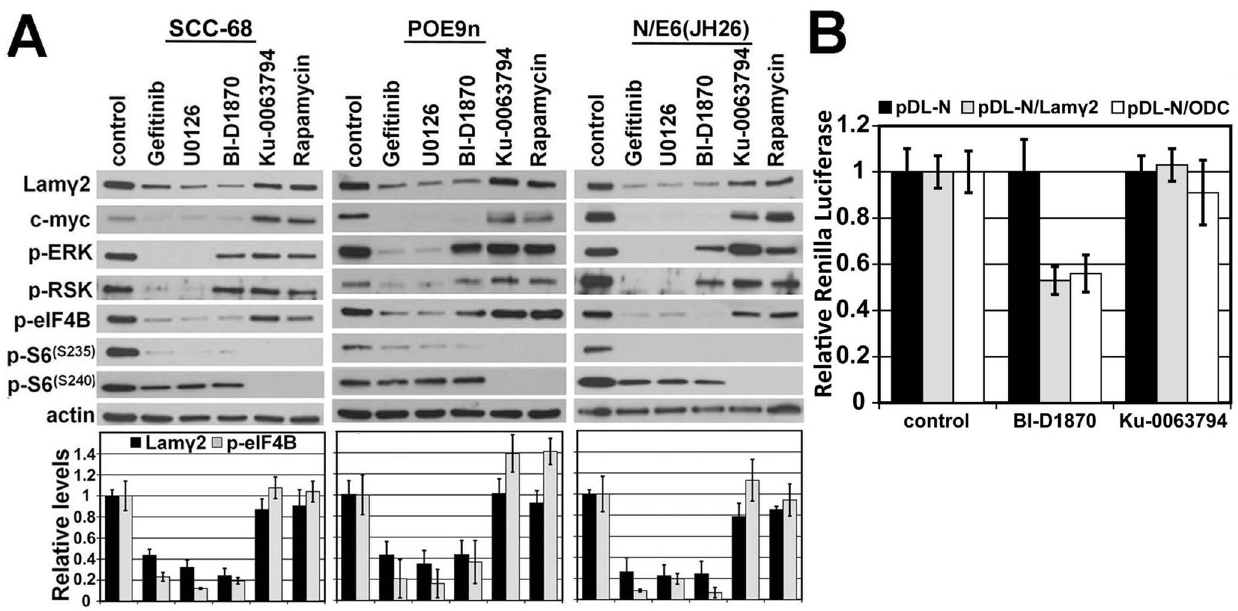
Figure 3. MAPK/RSK-dependent, mTOR/S6K1-independent activation of eIF4B and Lam c 2 mRNA translation. A ) Western blot analysis of confluent cultures of SCC-68, the premalignant oral keratinocyte line POE9n, and normal primary keratinocyte strain N engineered to express the JH26 mutant of HPV16 E6 (N/E6(JH26). Cultures were treated for 24 hr with the indicated kinase inhibitors and then analyzed for levels of Lam c 2 and MYC protein and for the phosphorylated, activated forms of signaling proteins and translation factors. The Lam c 2 band shown is the 155 kD intracellular form and not the 105 kD form that predominates after secretion and proteolytic processing. The bar graphs below show densitometric analysis of Lam c 2 and p-EIF4B levels in each drug treatment condition relative to untreated control cultures of each line, as described in panel B. B ) SCC-13 cells transfected with the reporter constructs pDL-N, pDL-N/(Lam c 2 5 9 -UTR), and pDL-N/(ODC 5- 9 UTR) with or without the RSK inhibitor BI- D1870 or the mTORC1/2 inhibitor Ku-0063794 and analyzed for Renilla and Firefly luciferase activity. Reduction caused by BI-D1780 in Lam c 2 5 9 UTR- and ODC 5 9 UTR-dependent expression had P values for significance of 0.0043 and 0.01, respectively.